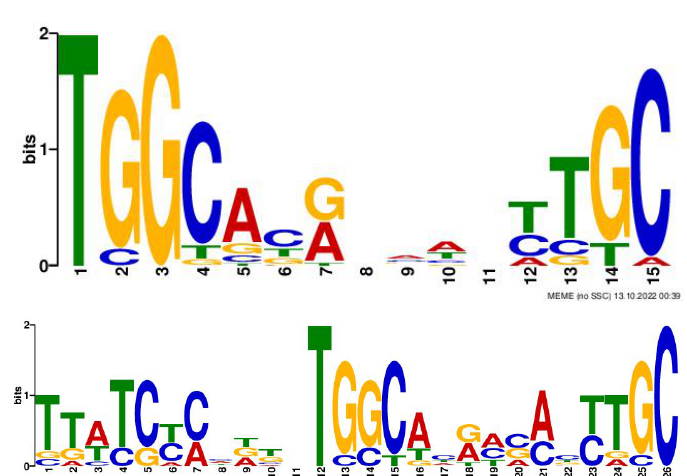
Figure 5. Motif Analysis: Learned motifs of the kernels of the first Conv1D can be considered position weight matrices